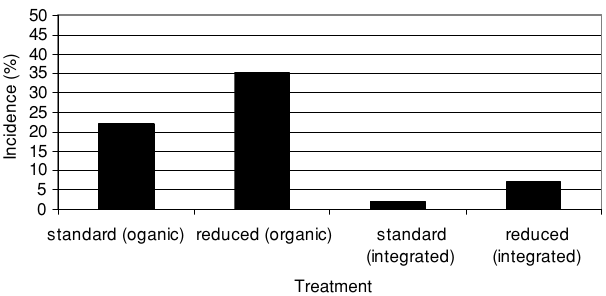
Figure 7. Efficacy of standard and reduced spray programmes on incidence of codling moth damage on fruit in integrated and organic apple orchards (LSD = 3.7 – integrated; LSD = 10.4 – 0.05 0.05